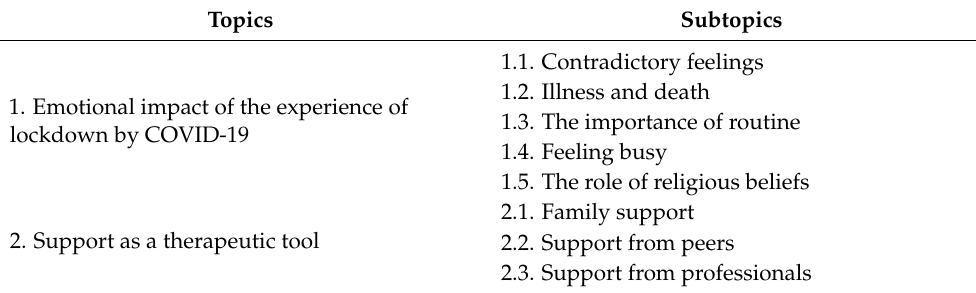
Table 3. Main themes and